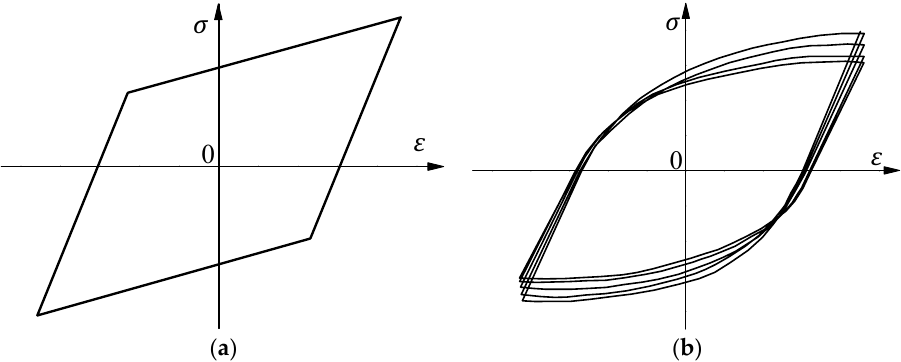
Figure 10. Hysteresis curves under different stress-strain constitutive relations. ( a ) Bilinear model; ( b ) Basic requirements of the hysteresis model.